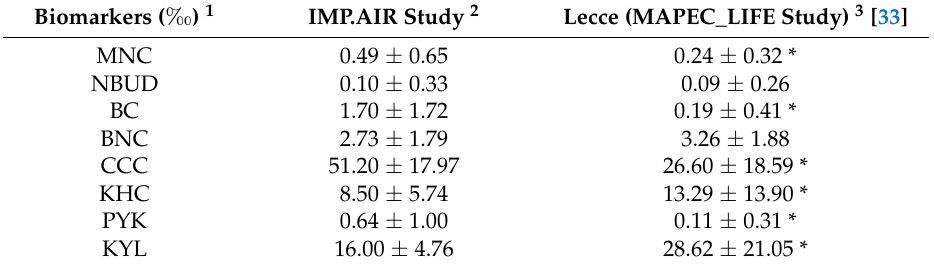
Table 7. Frequency ± SD of chromosome damage markers (MNC and NBUD), cell proliferation markers (BC and BNC), and cell death markers (CCC, KHC, PYK and KYL) in exfoliated buccal cells (EBC) of children involved in the IMP.AIR study compared with children living in Lecce and included in the cohort of MAPEC_LIFE study